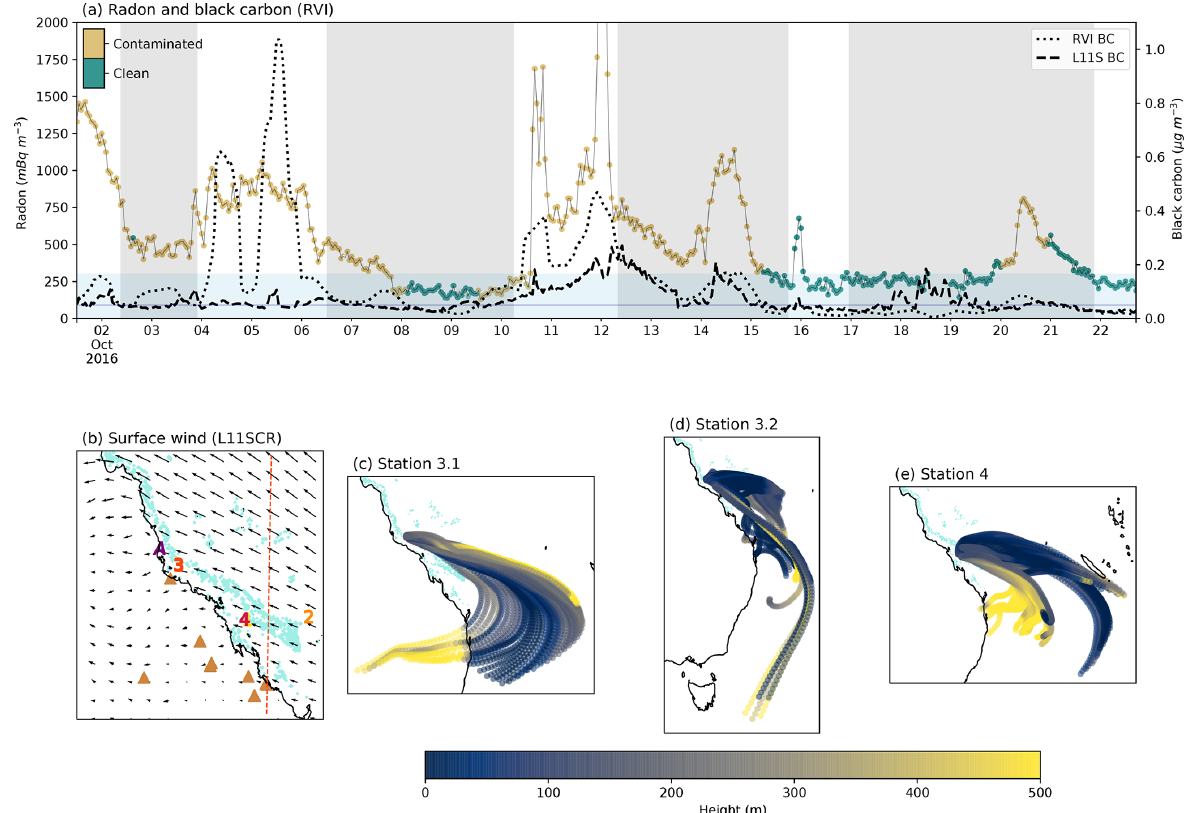
Figure 4. (a) Radon concentrations from the RVI and coloured by the ship exhaust flag (left axis). Black carbon concentrations (right axis) from the RVI (dotted line) and L11S (dashed line). The light blue shading indicates when radon was below 300mBqm − 3 , and the dark blue line indicates black carbon below 0.05µgm − 3 . The grey shading represents ship stations 2, 3.1, 3.2 and 4. (b) the surface winds from L11SCR. Coral reefs are shown in light blue. Numbers indicate RVI observation stations 1–4 coloured yellow through to red, and the purple A indicates the AIRBOX location. The brown triangles indicate where fossil fuel power generators are located, and the dashed orange vertical line indicates where a transect was taken for vertical profile analysis. (c–e) HYSPLIT back trajectories for every 2h while the ship was at station 3.1, 3.2 and 4 respectively, coloured by